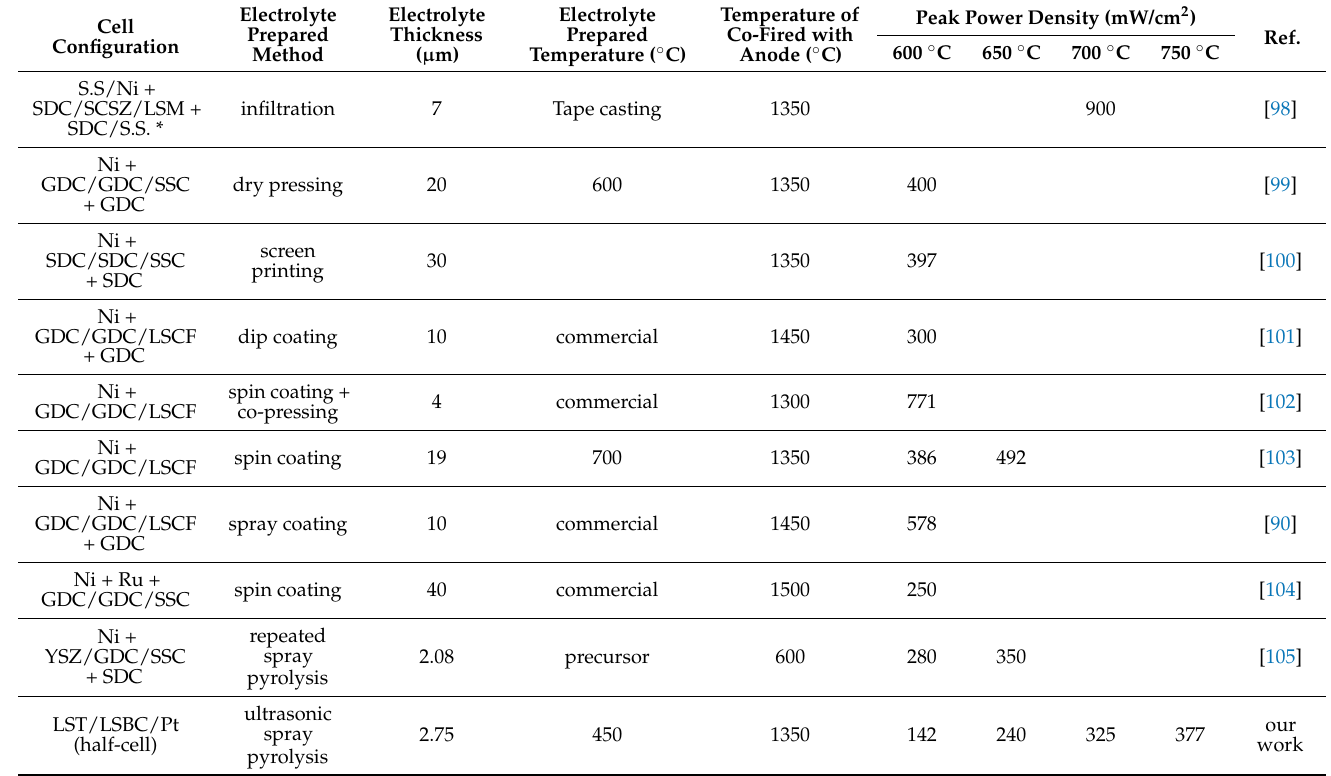
Table 1. Functional comparisons of anode-supported SOFCs with thin layer of ceria-based electrolyte operated in H 2 (or humidified H 2 ) as fuel and air as oxidant atmosphere (cited from the literatures and this